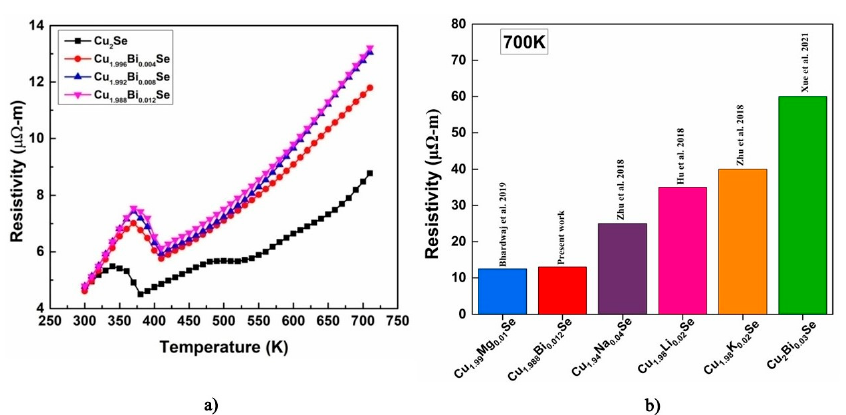
Table 6 . Parameters obtained from power law (Equation (9)).